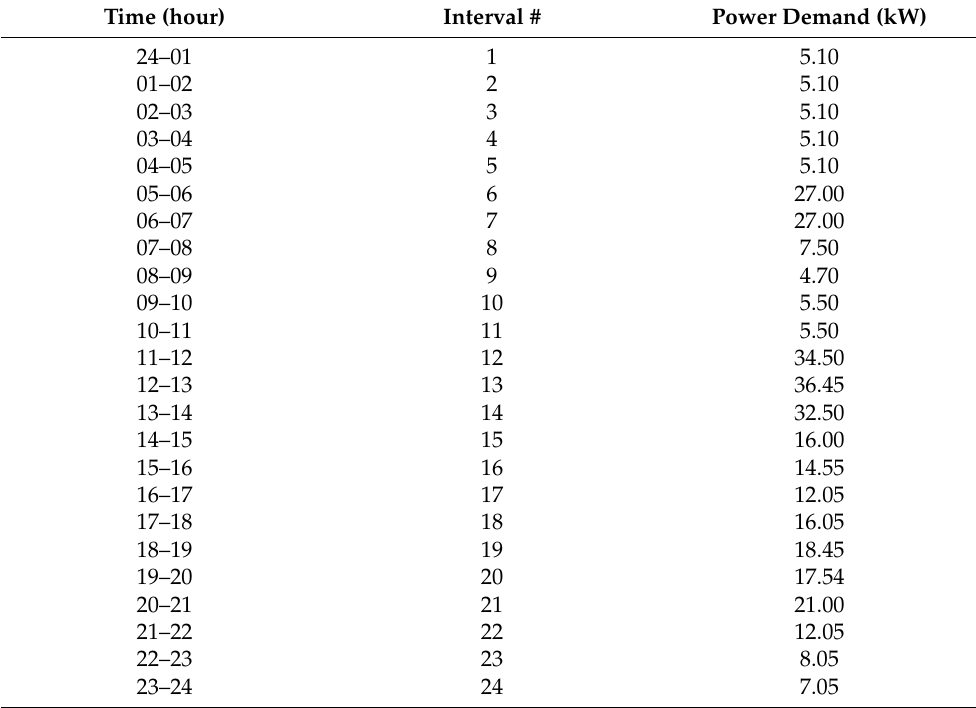
Table 7. Load profile data for the rural